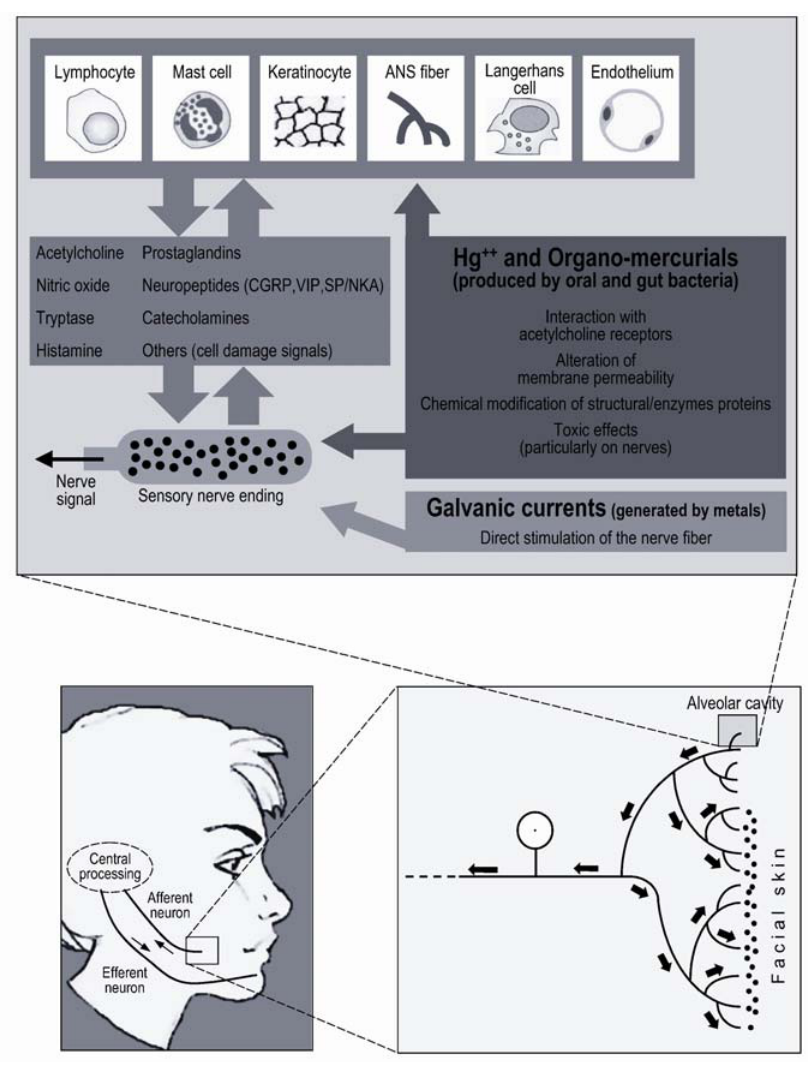
FIGURE 3. Schematic representation of possible pathogenic mechanisms involving the cholinergic system in neurogenic